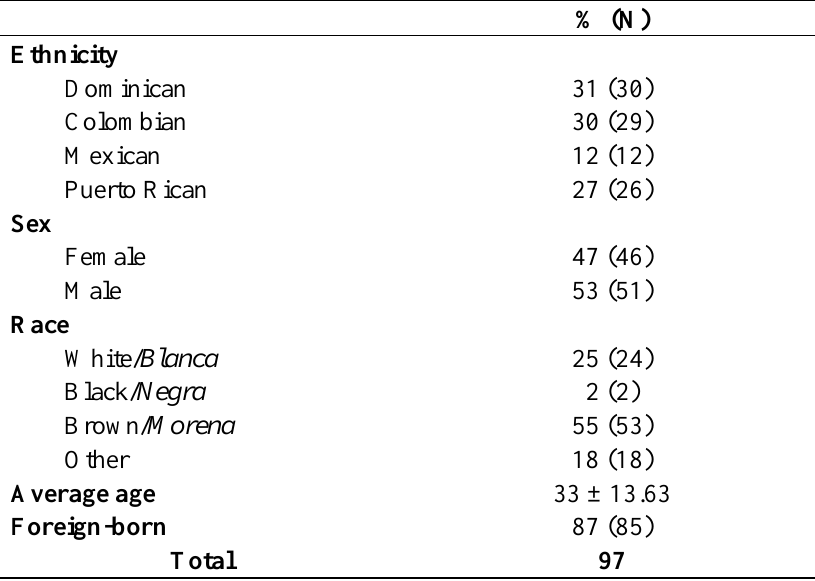
Table 1. Sample demographic